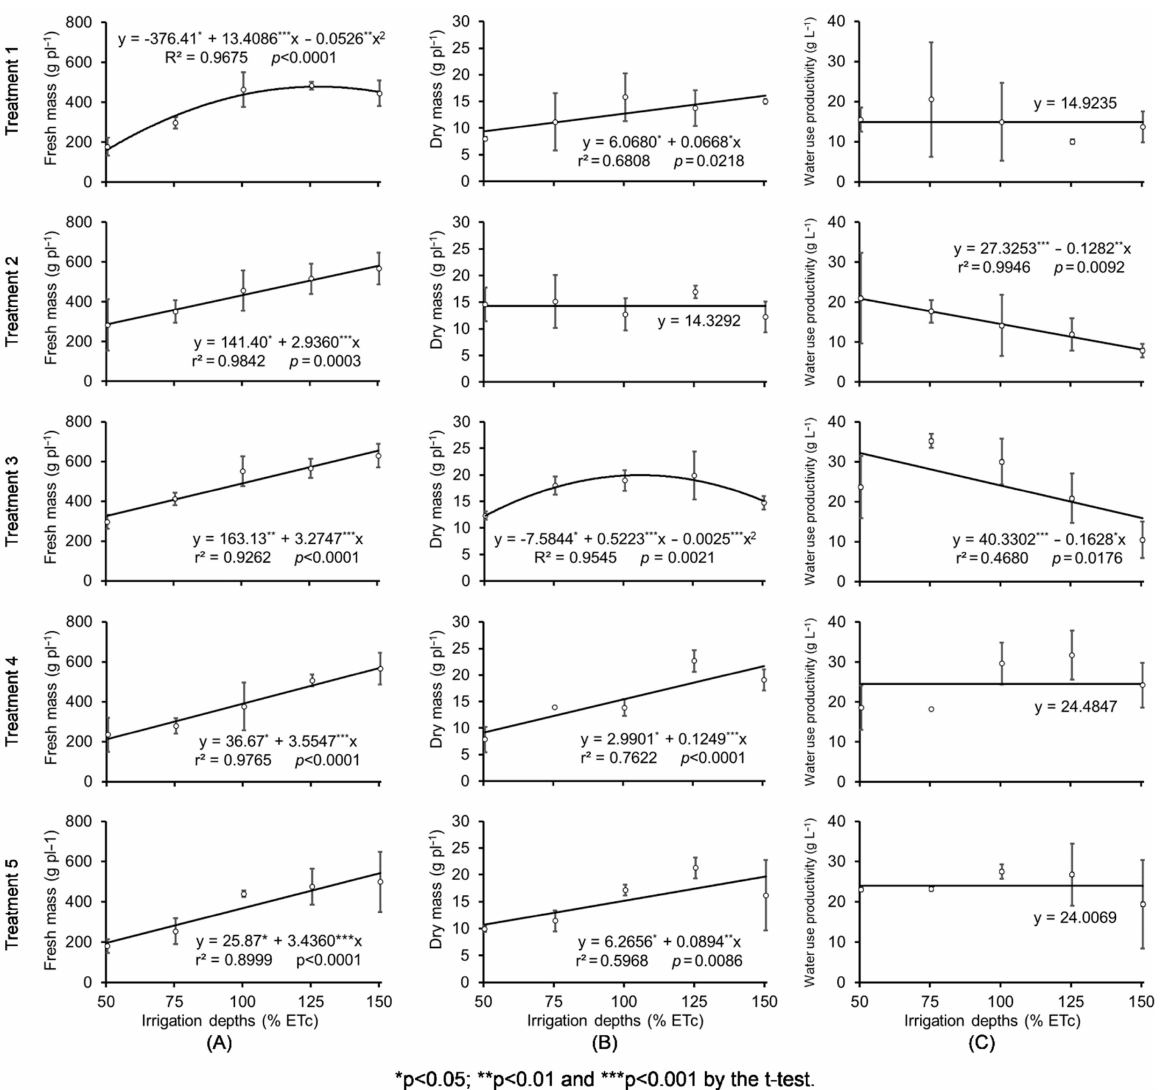
Figure 7. Shoot fresh mass ( A ), shoot dry mass ( B ) and water-use productivity ( C ) of lettuce as a function of different irrigation depths and cultivated in cycle 2. T1—treatment irrigated with human-supply water from the concessionaire and planting and top-dressing. Table 4. Results of microbiological analyses of lettuce crop performed in the two cycles.